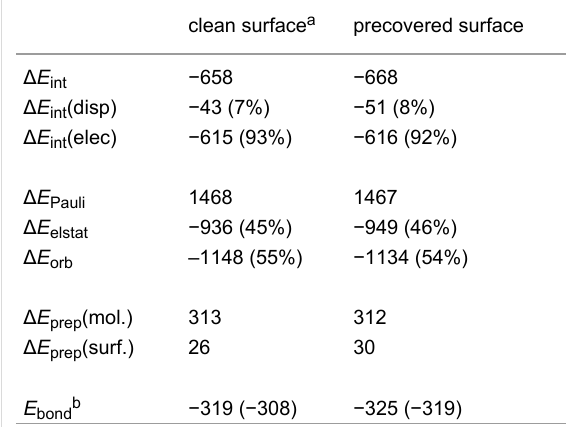
Table 3: Energy decomposition analysis (pEDA) results (PBE-D3/ TZ2P) for the adsorption of 1 on a clean and precovered Si(001) sur- face. All values in kJ·mol − 1